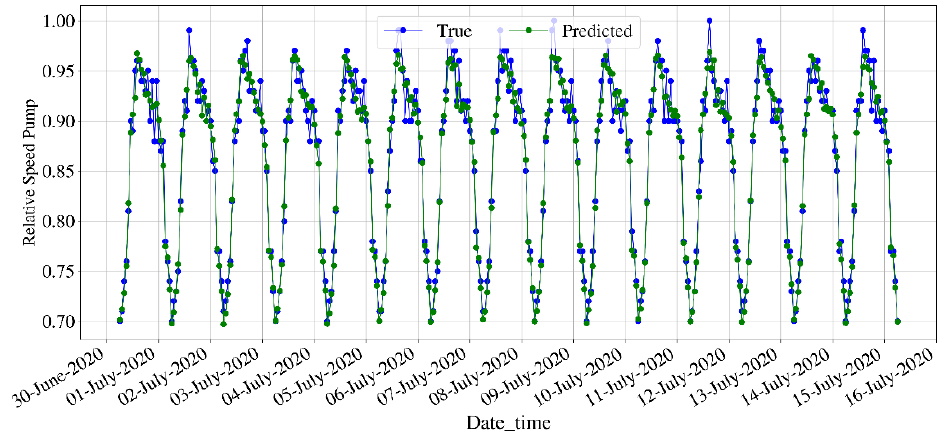
Figure 4. Comparison between estimated and real relative pump speed for Patios-Villa del Rosario WDS.